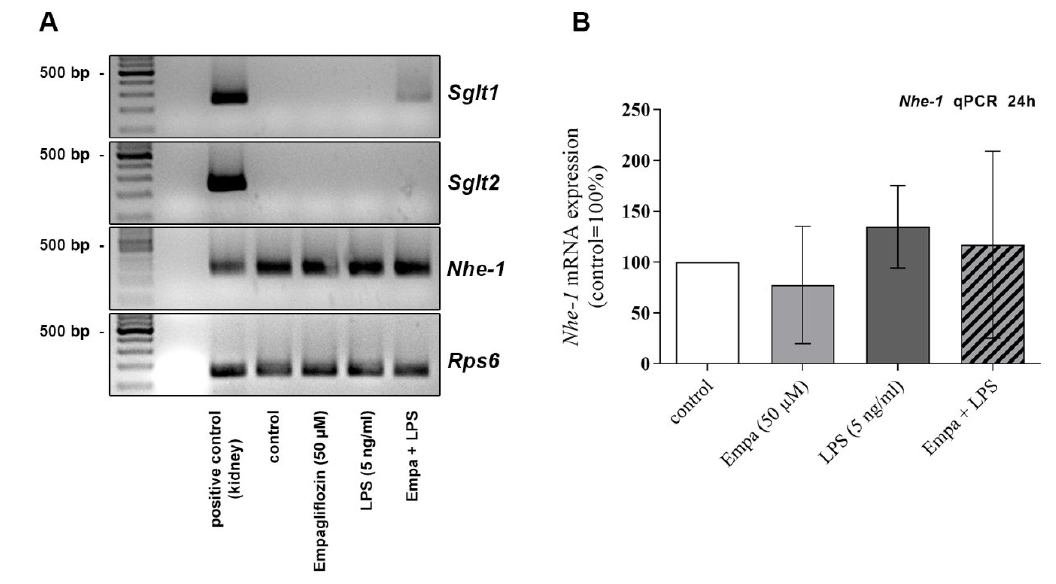
Figure 8. Sglt1 , Sglt2 and Nhe-1 mRNA expression in primary microglia was measured using RT-qPCR. Kidney was used as positive control. Migration profiles of RT-qPCR products on agarose gel ( A ). Nhe-1 was expressed at high levels in primary microglia ( A , B ) whereas Sglt1 and Sglt2 ( A ) expression was barely detectable. Stimulation for 24 h with empagliflozin and LPS, alone or in combination, did not alter the Nhe-1 mRNA expression ( B , one-way ANOVA, followed by Tukey test; F-value = 1.242; n = 6).